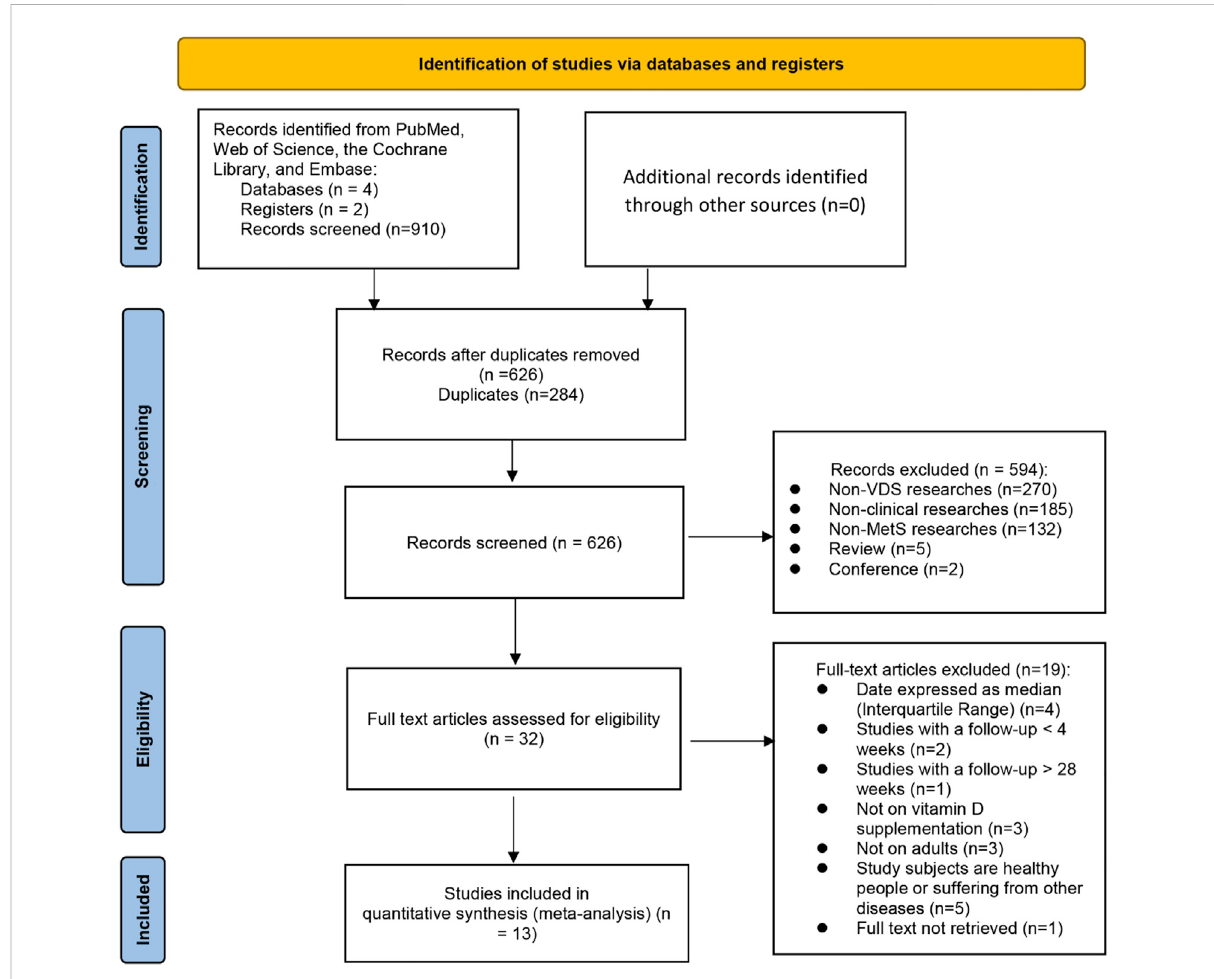
FIGURE 1 Preferred Reporting Items for Systematic Reviews and Meta-Analyses (PRISMA) diagram of study